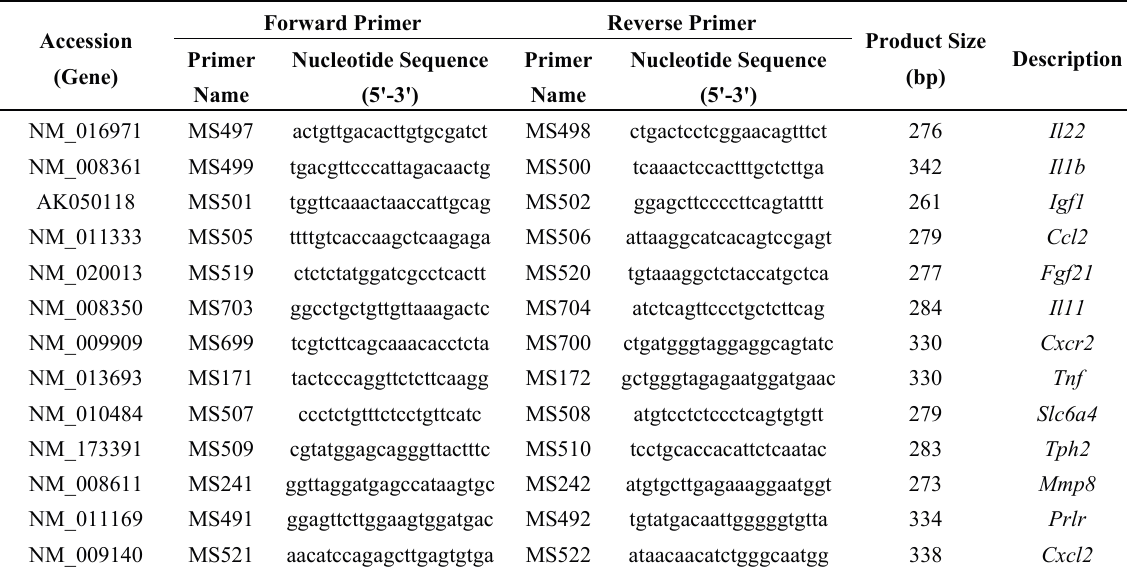
Figure 2. Total RNA visualized by agarose gel electrophoresis ( A ) followed by mRNA expression profiles of GAPDH and β -actin genes used a positive control ( B ) to confirm equal loading and proper cDNA synthesis. In ( A ), lane numbers 1 to 8 and 9 to 16 indicate 6 and 24 h samples (1/9 = sIC, saline ischemic core; 2/10 = pacapIC, PACAP38 ischemic core; 3/11 = sIP, saline Ischemic Penumbra; 4/12 = pacapIP, PACAP38 ischemic penumbra; 5/13 = sHC, saline healthy core; 6/14 = pacapHC, PACAP38 healthy core; 7/15 = sHP, saline healthy penumbra; 8/16 = pacapHP, PACAP38 healthy penumbra), respectively; and in ( B ), gel images on top show PCR product bands stained with ethidium bromide; band intensities are also presented graphically below for clarity.